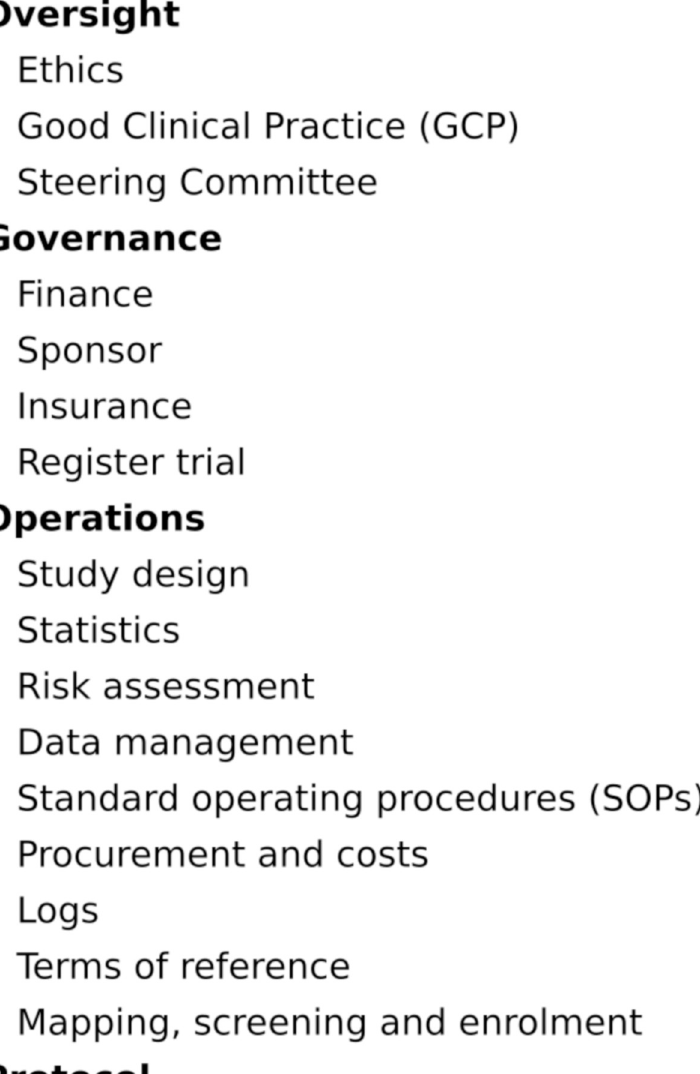
Fig 1. NVivo node tree. The tree consists of a hierarchy of parent nodes and nodes for organizing text passages from data (coding). Parent nodes are in bold. For the parent node Operations , key nodes are shown only.